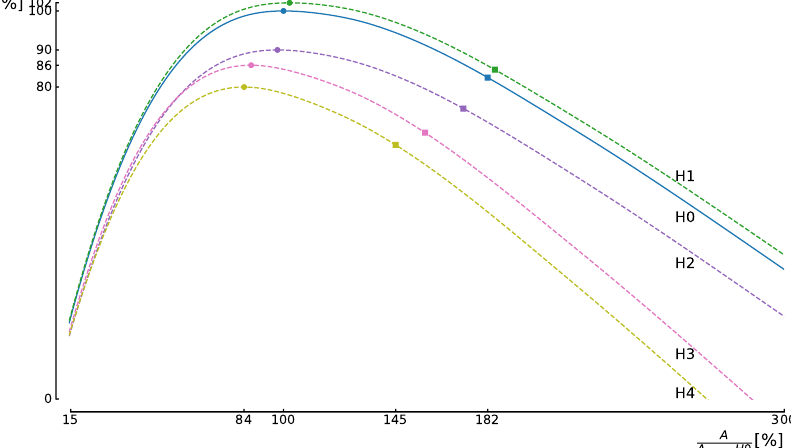
Figure 8. Impact of the assumptions on the energetic and economic